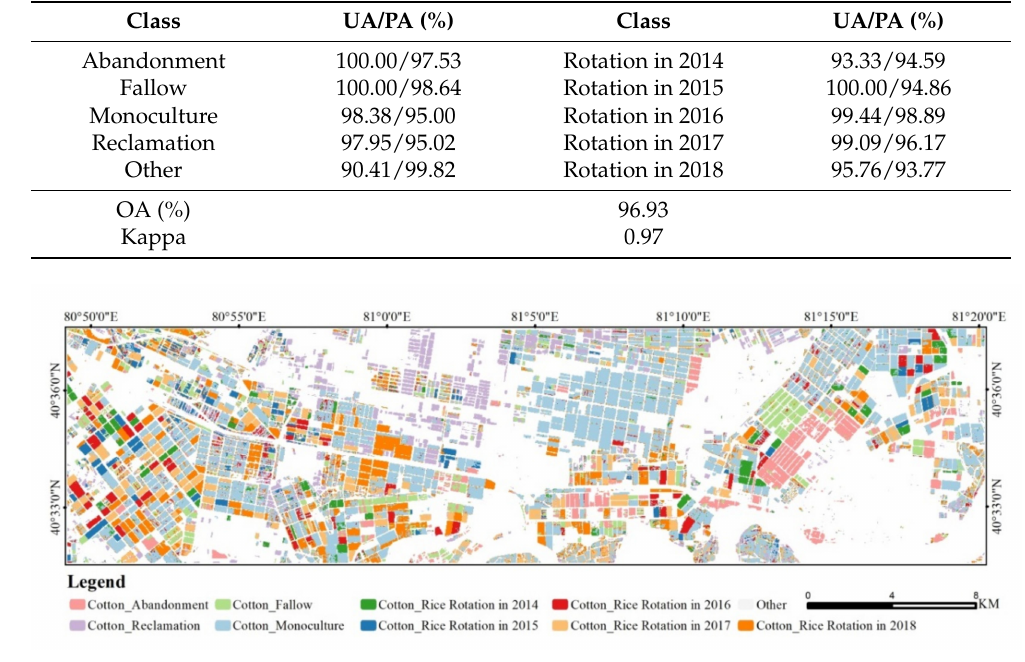
Figure 8. Multi-year cotton-cropping pattern between 2014 and 2018.